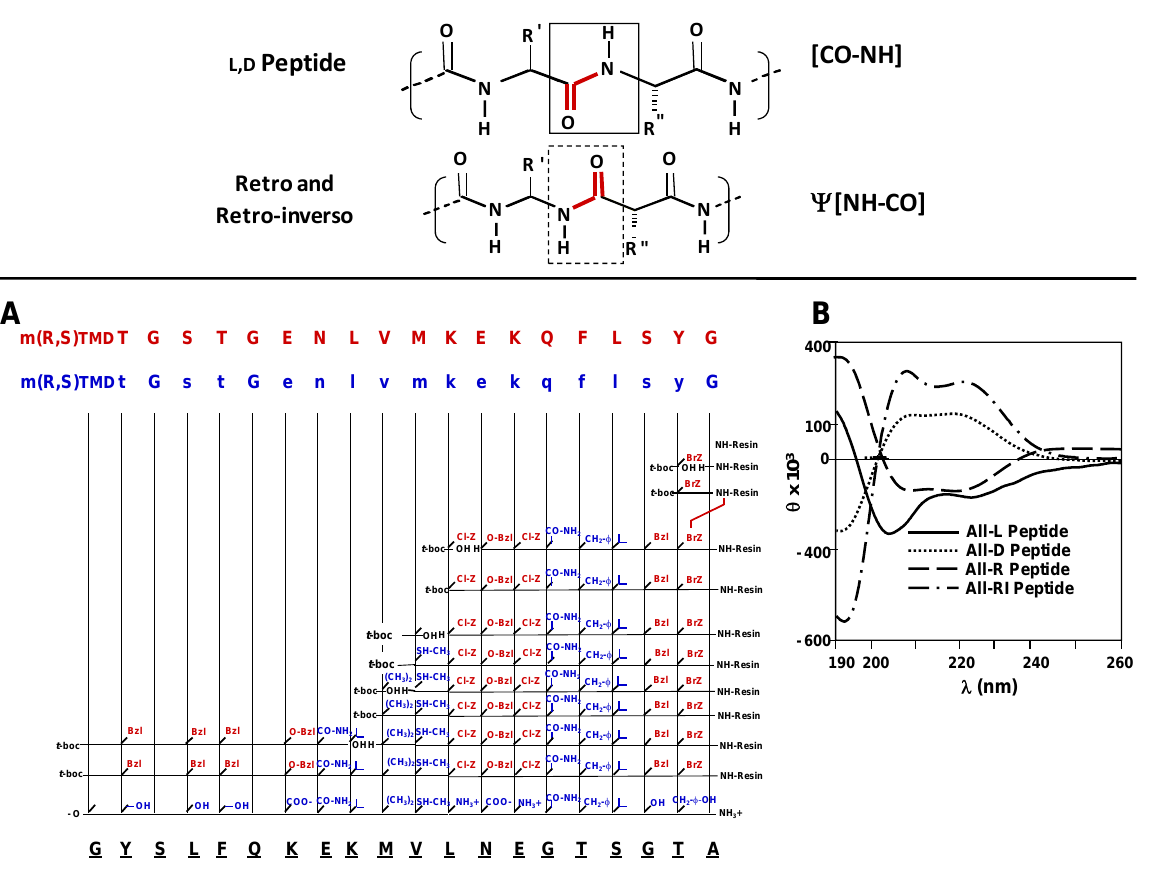
Figure 3. Obtaining all-Retro and all Retro-inverso analogue sequences. A . Solid phase synthetical strategy. B. Circular dichroism analysis for stereochemical- and topochemical- modified MSP-1 42–61 pseudopeptides. Overlay of the CD spectra of L , D , Retro, and Retro- inverso MSP-1 42–61 analogues, small characters represent D -amino acids. Mean residue ellipticity [  ] is shown in degrees cm 2 dmol -1 . L -Amino acids are described in capital letters and D-residues as small characters. All-D 1513 (dotted profile), all-Retro analogue (dashed profile); all- D (dotted profile) and all-Retro-inverso (dashed-dotted